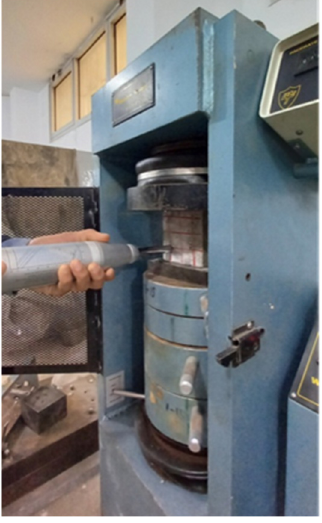
Figure 5. Rebound hammer test setup.